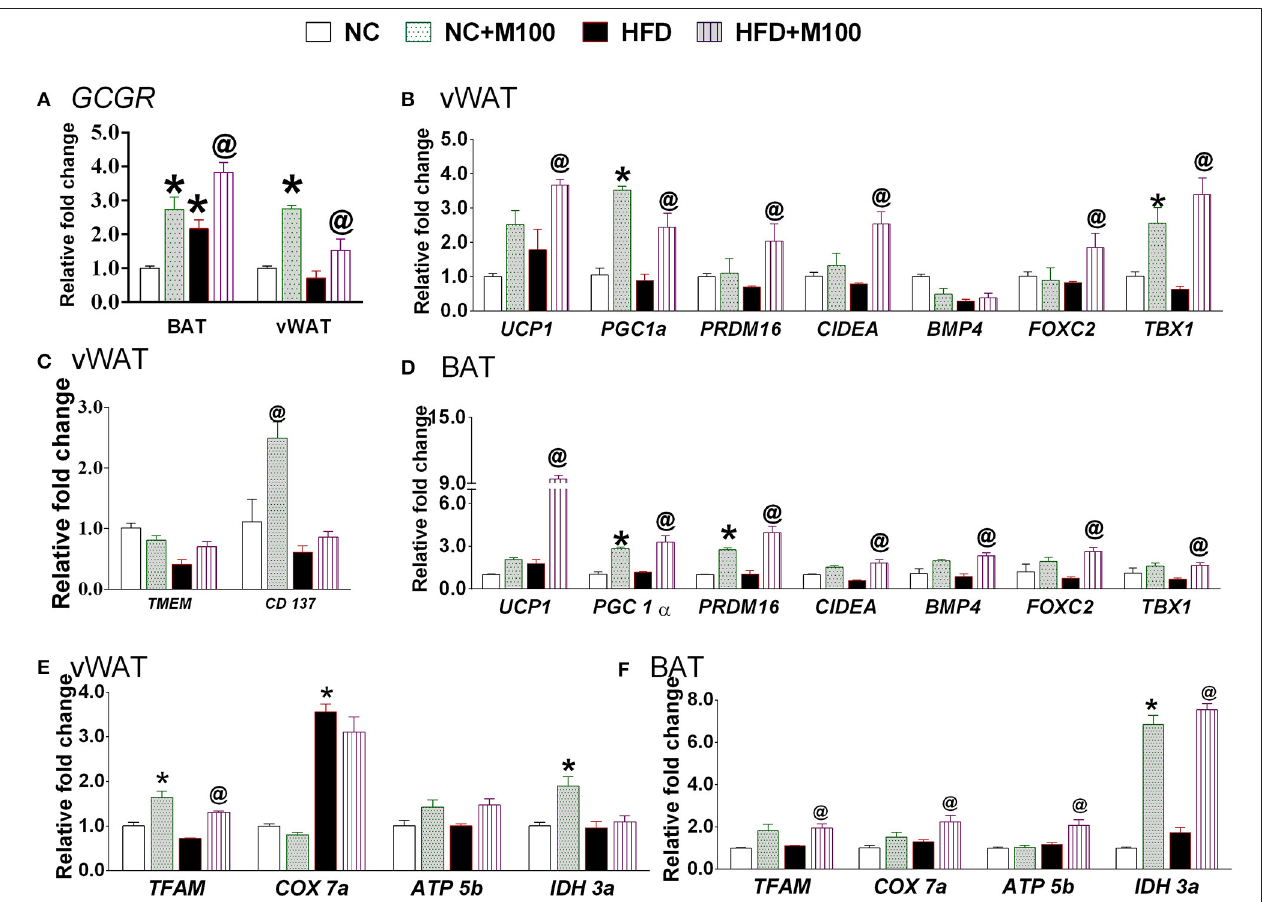
FIGURE 5 | Effect of chronic administration of menthol in energy expenditure related parameters in adipose tissue. (A) Glucagon receptor (GCGR) in vWAT and BAT; (B) energy expenditure genes in vWAT; (C) beige cell marker genes in vWAT; (D) energy expenditure genes in BAT; (E) mitochondrial activity marker gene in vWAT; (F) mitochondrial activity marker gene in BAT. NC, normal rodent chow fed; HFD, high fat diet fed; HFD + M100, HFD fed plus daily administration of 100 mg/kg menthol ( p.o. ); NC + M100, NC fed plus daily administration of 100 mg/kg menthol ( p.o. ). n = 3; All the values are expressed as mean ± S.E.M; Analysis was carried out by one way ANOVA followed by Tukey’s multiple comparison; * p < 0.05 HFD and NC + M100 vs. NC; @ p < 0.05 HFD + M100 vs. HFD fed group.